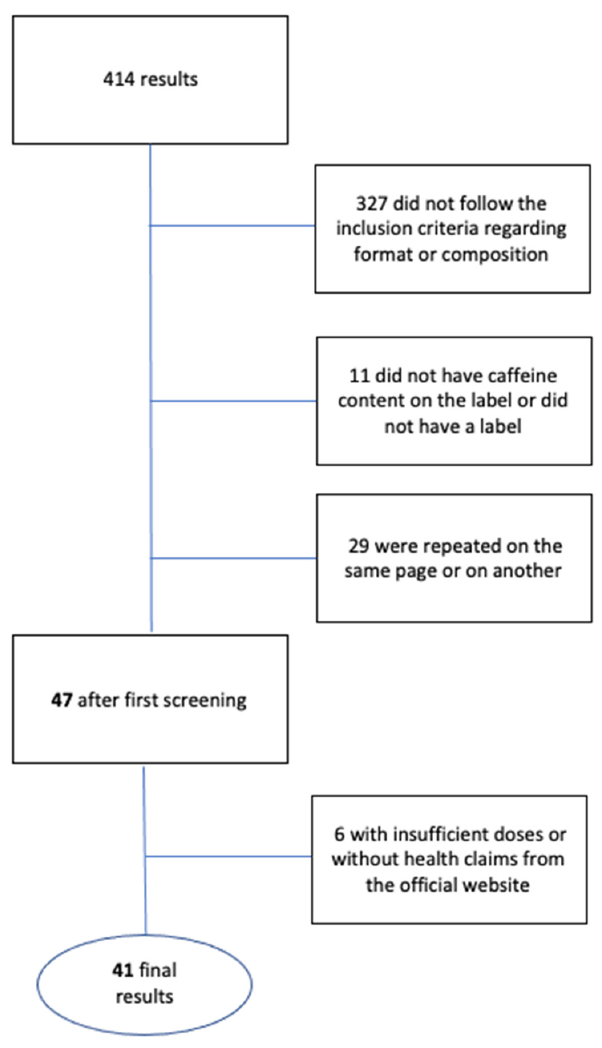
Figure 1. Flow diagram showing how the study sample was